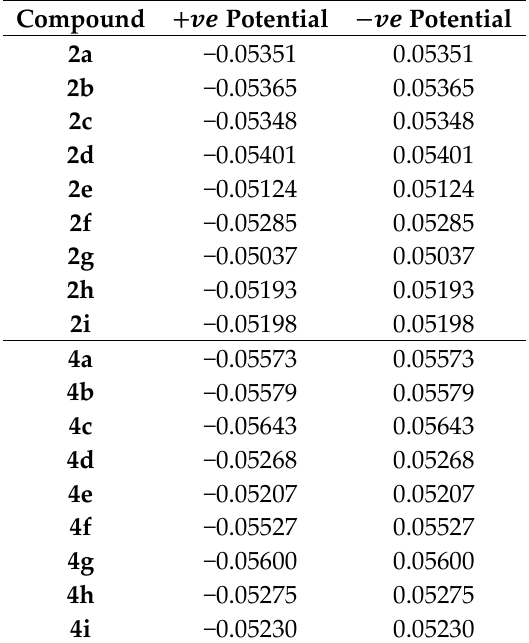
Figure 2. MEP surfaces of the newly synthesized pyridine derivatives viz . 2a – 2i , 3 , 4a – 4i at B3LYP/ 6-31G(d,p) level of DFT Table 3. The +(cid:1874)(cid:1857) and – (cid:1874)(cid:1857) potential values from the MEP analysis of compounds 2a – 2i and 4a – 4i